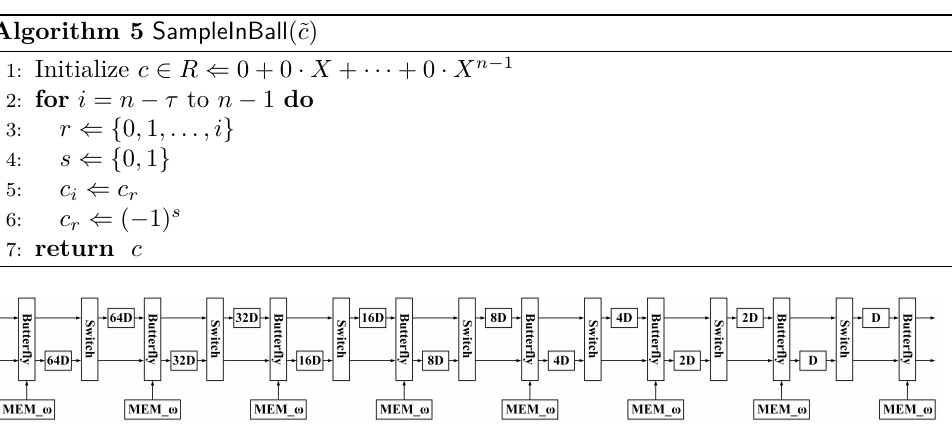
Figure 1: Block graph of a 256-point R2MDC